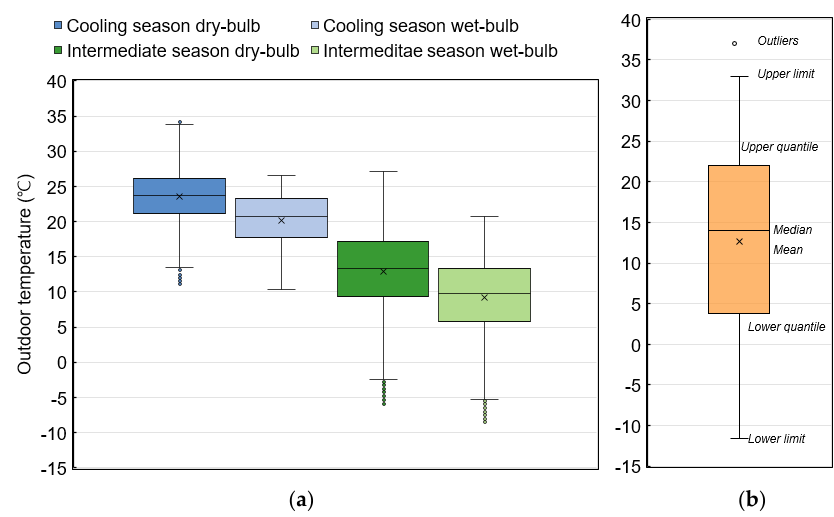
Figure 8. Cooling and intermediate season outdoor air condition in Seoul (Climate zone 4A). ( a ) Cooling and intermediate season outdoor dry and wet-bulb temperature. ( b ) box plot example.